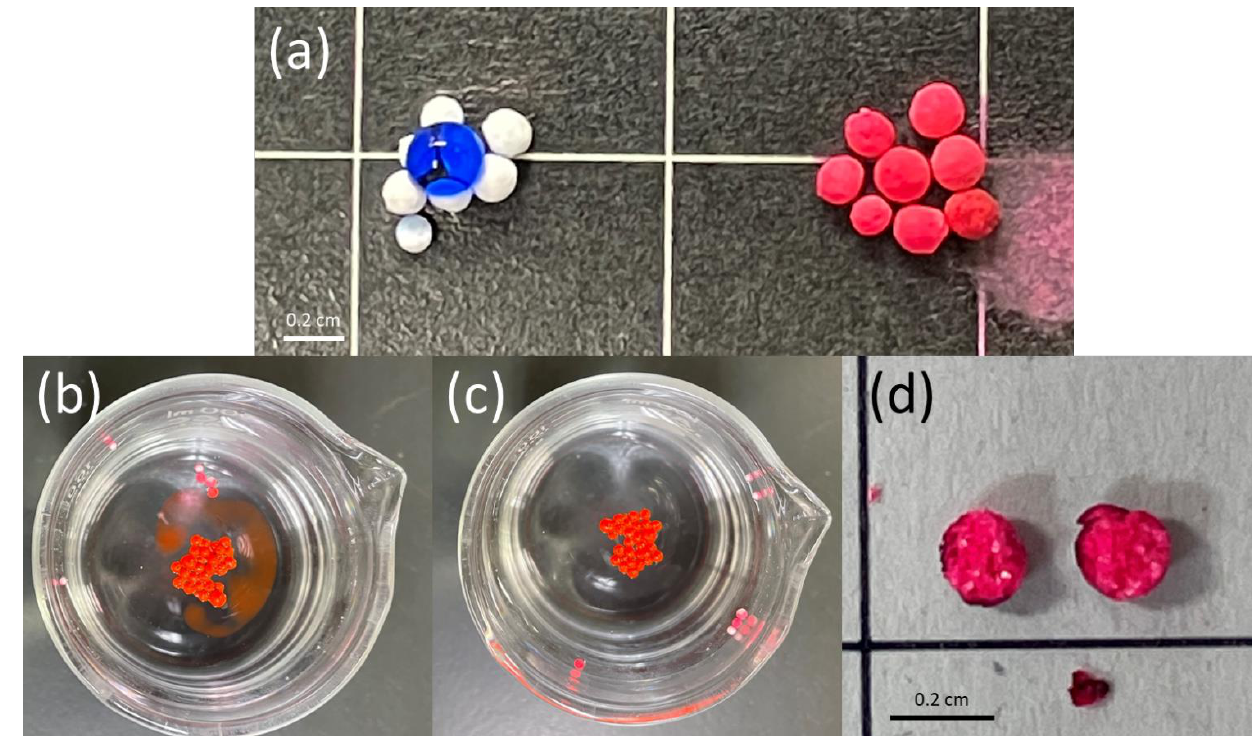
Figure 4. Hydrophobicity of pTrim cryogel particles ( a ) left; aqueous droplet on the particles, right; organic droplet on the particles. The adsorption of organic solvent from water by pTrim cryogel particles ( b ) 3 sec and ( c ) 10 sec. ( d ) Appearance cross section of the particle after adsorption organic solvent.